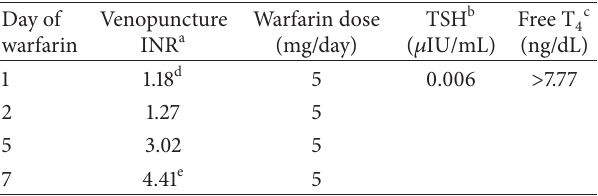
a INR: international normalized ratio, goals 2-3.